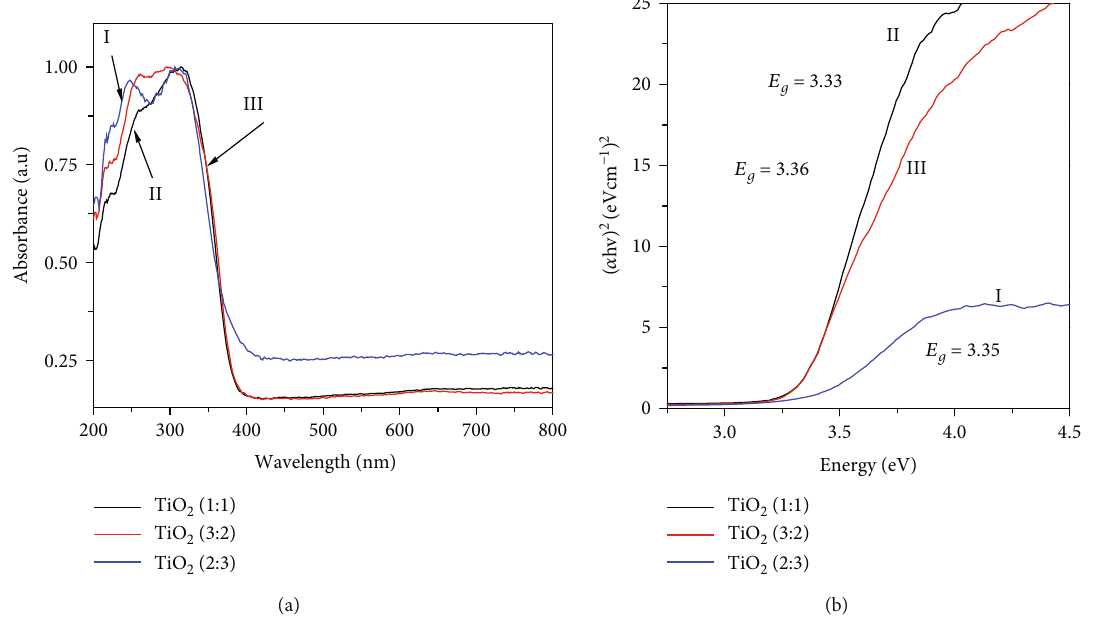
Figure 9: UV-Vis spectra (a) and Tauc plot of TiO